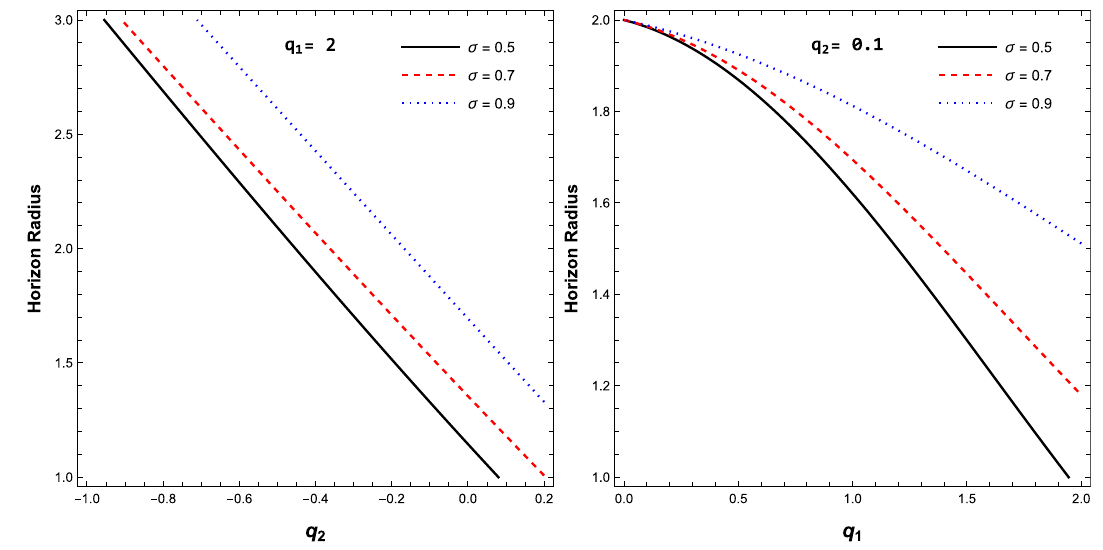
Fig. 4 Thedependence ofhorizon radius on q 1 and q 2 for threevalues of σ . Thesolidblacklines,dashedredlinesanddottedgreenlinescorrespond to σ = 0 . 5, σ = 0 . 7 and σ = 0 . 9, respectively. In the left plot q 1 is fixed and in the right plot q 2 is